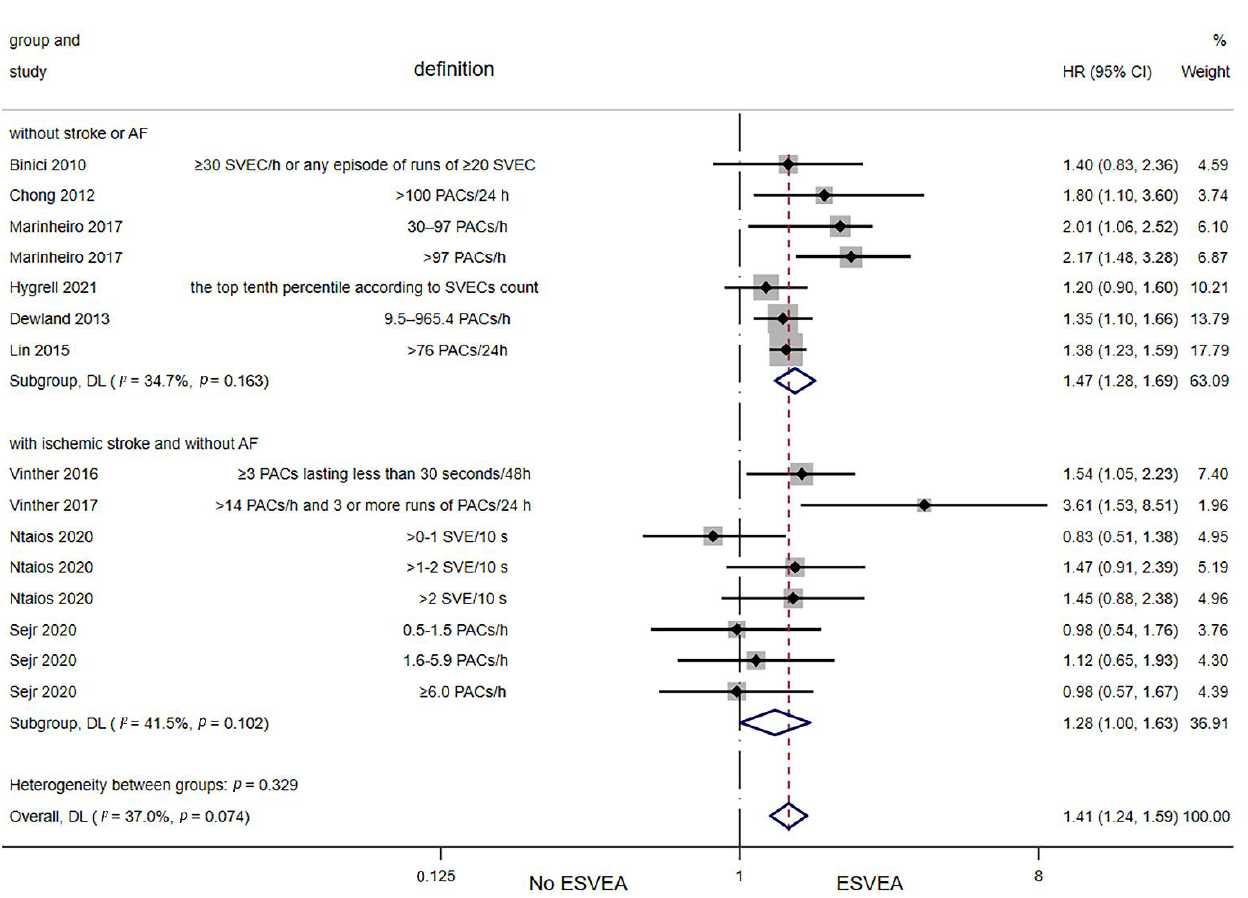
Figure 6. Forest plot of the association between ESVEA and all-cause mortality. Abbreviations: SVEC — supraventricular ectopic complexes; PACs — premature atrial complexes; SVE — supraventricular extrasystoles; ESVEA — excessive supraventricular ectopic activity; HR — hazard ratio; CI — confidence interval. Definition represents the definitions of ESVEA in different studies. [12 – 14,22,35,36,39,40,43,45]